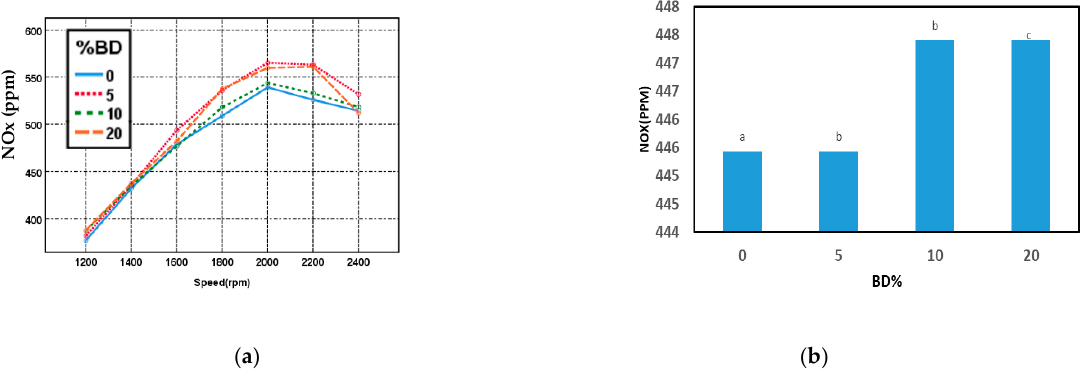
Figure 8. ( a ) NOx vs. S at 100% load; ( b ) mean values of total data of NOx for different speeds and loads. The letters a-d inside the diagram indicate significant differences ( P ≤ 0.05).